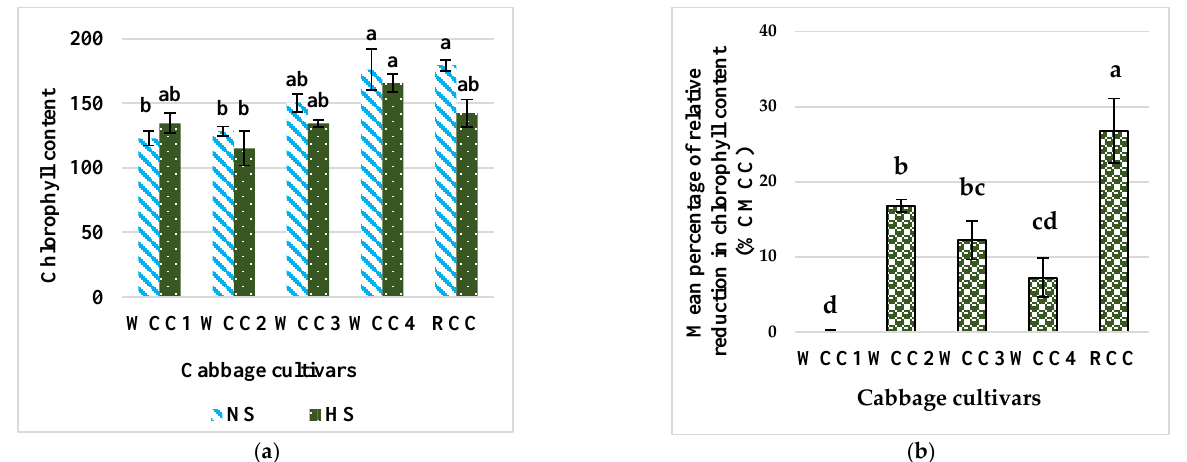
Figure 2. Mean phenotypic expression of chlorophyll content. ( a ) CM1000™ chlorophyll content index values and ( b ) mean percentage of relative reduction in chlorophyll content in five cabbage cultivars under HS (at 42 °C; for 5h) and NS (25 °C) conditions. Bars denote the mean of at least 5 measurements ± SE ( n = 5). Mean values within each cultivar with different letters are significantly different based on Tukey’s HSD test at p < 0.05.